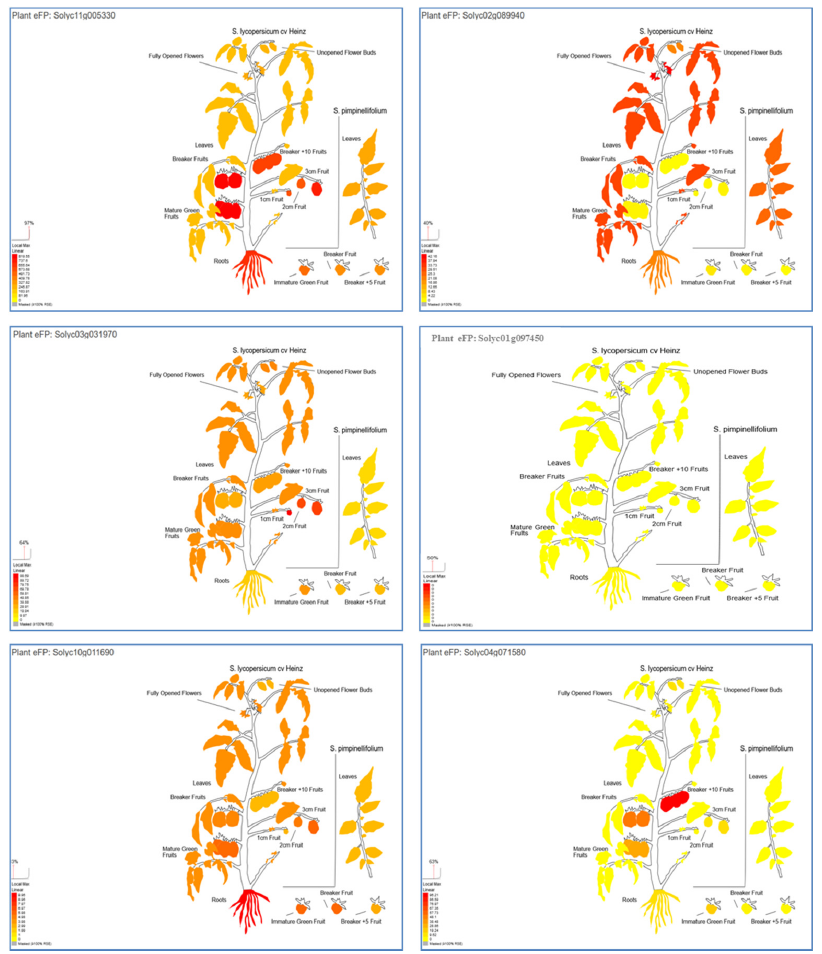
Figure 2. The putative “plant electronic fluorescent pictograph” tissue expression of Solyc11g005330, Solyc02g089940, Solyc03g031970, Solyc01g097450, Solyc10g011690 , and Solyc04g071580 genes of differ- ent tissues and developmental stages. The more intense the red color of the expression bar, the more gene expression detected